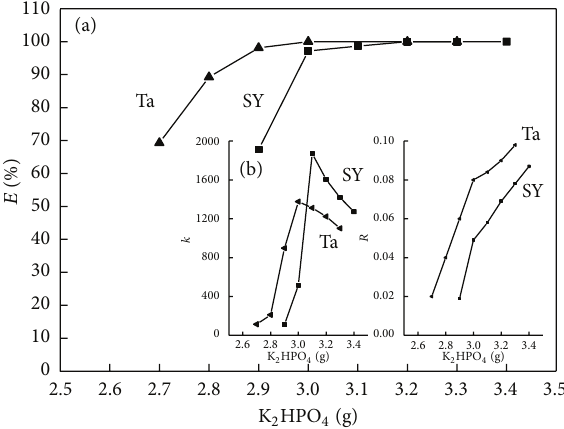
Figure 3: Effects of K 2 HPO 4 amount on extraction efficiency, partition coefficient, and phase ratio ( 𝑚 = 0.30 mL). 𝑉 IL